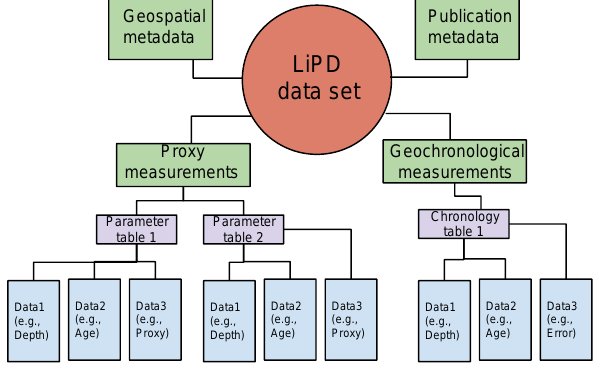
Figure 1. Schematic data model example of Linked Paleo Data.